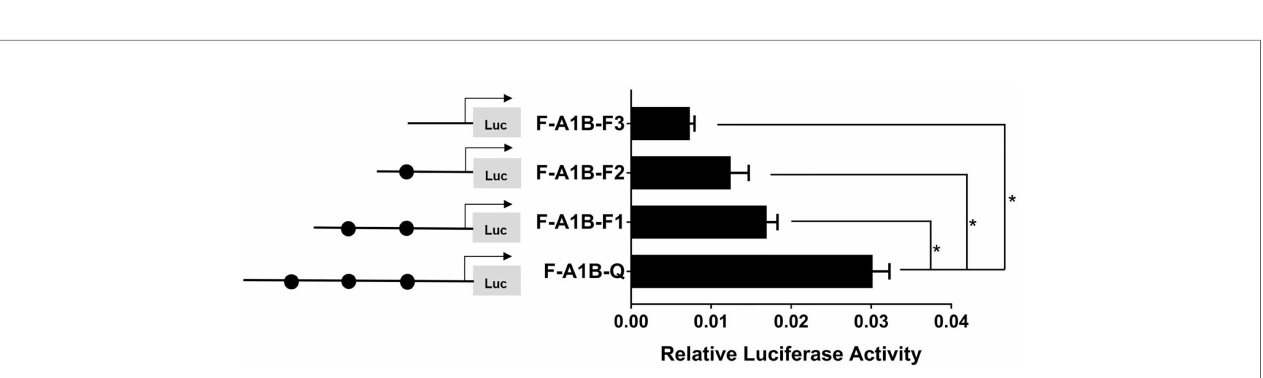
FIGURE 11 | Effect of SF-1 on the transcriptional activity of the cyp19a1b promoter fragment mutated at the transcriptional site. On the left is a schematic diagram of the mutation of the promoter site, and the triangle represents the binding site. The right side is the expression of luciferase in the promoter recombinant vector. The black triangle with a red cross represents the SF-1 mutation site. One-way ANOVA was performed on the data expressed as mean ± standard deviation (n = 4). *There is a signi fi cant difference between the data.